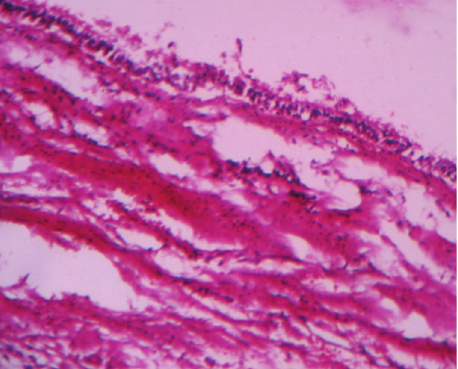
Figure 12: Histopathological section shows features of residual